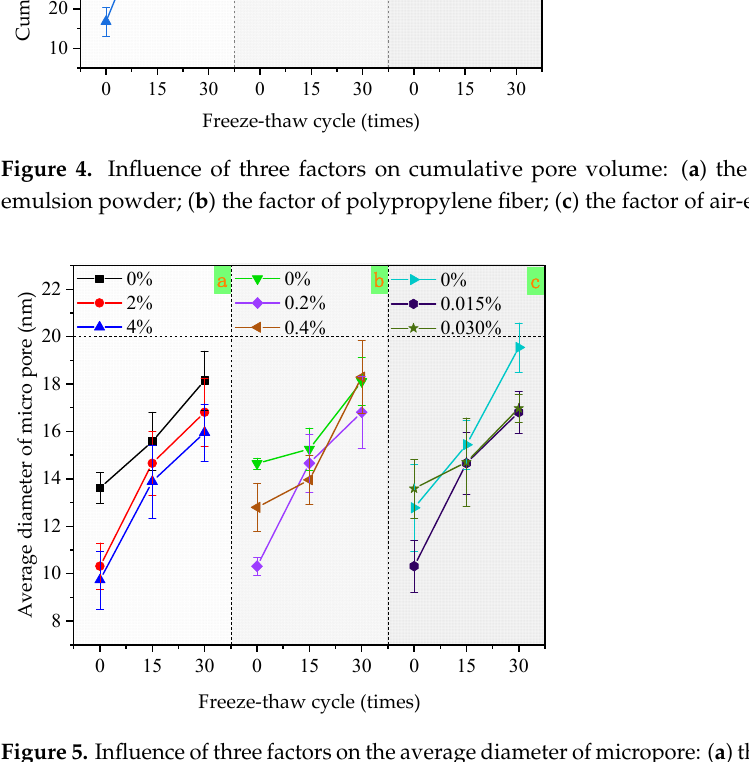
Figure 5. Influence of three factors on the average diameter of micropore: ( a ) the factor of redispersible emulsion powder; ( b ) the factor of polypropylene fiber; ( c ) the factor of air-entraining